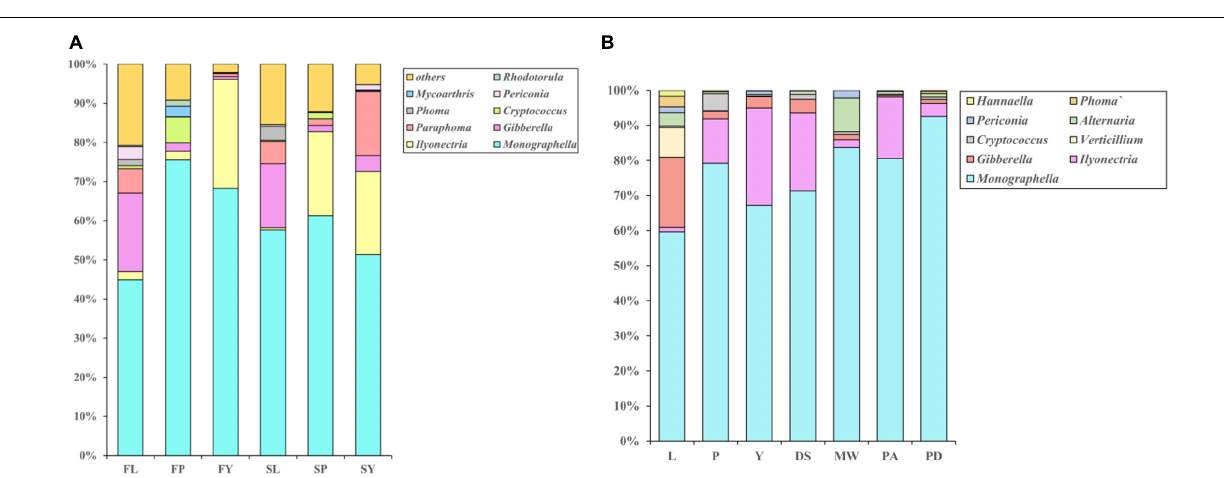
FIGURE 7 | (A) Bar diagram of community composition of L. chuanxiong endophytic fungi at different growth stages. FL refers to the LZ in the first cultivation cycle; FP refers to the PX in the first cultivation cycle; FY refers to the CX in the first cultivation cycle; SL refers to the LZ in the second cultivation cycle; SP refers to the PX in the second cultivation cycle; SY refers to the CX in the second cultivation cycle. (B) Relative abundance of endophytic fungi in L. chuanxiong . DS refers to Shiyang town, Dujiangyan, Sichuan province; MW refers to Wansheng town, Meishan, Sichuan province; PA refers to Aoping town, Pengzhou, Sichuan province; PX refers